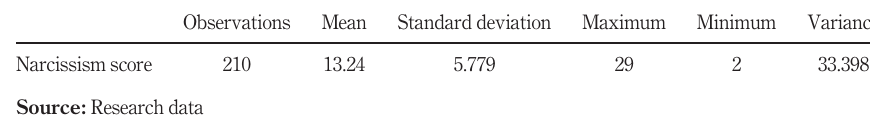
Observations Mean Standard